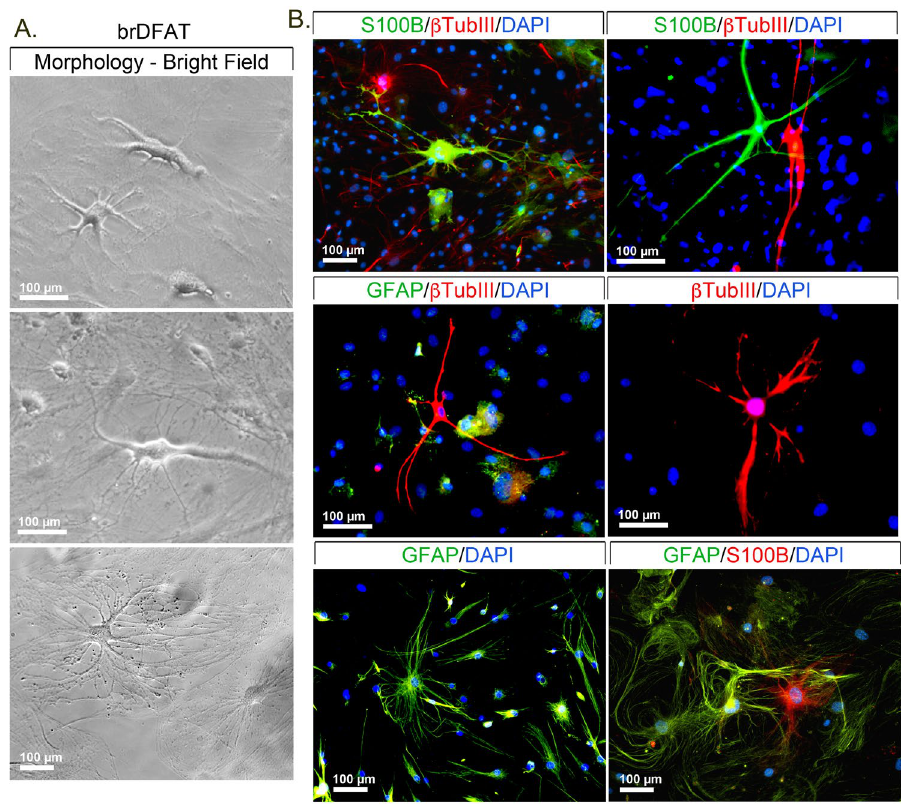
Figure 3. Mouse brDFAT cells in culture with neurogenic characteristics. ( A ) Bright field images of brDFAT cells after 15 days of culture in neural induction medium. ( B ) Expression of S100 Calcium Binding Protein B (S100β, green), β tubulin III (βTubIII, red), and glial fibrillary acidic protein (GFAP, green) as visualized by immunofluorescence in brDFAT cells after 15 days of culture in neural induction medium. DAPI (blue) was used to visualize nuclei. Representative images from 3–5